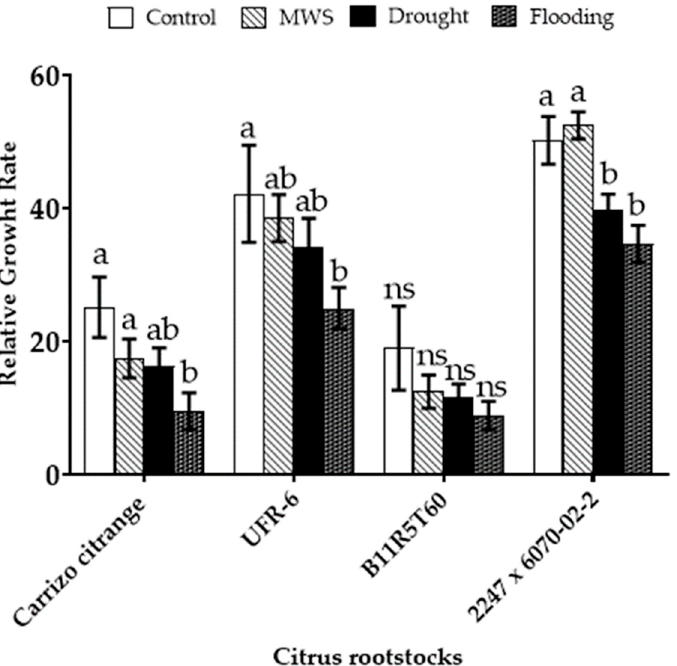
Figure 3. Relative growth rate (RGR; day − 1 ) after 30 days (D30) under four water treatments (Control, MWS, Drought, and Flooding) and with four citrus rootstocks assayed (Carrizo citrange, UFR-6, B11R5T60, and 2247 x 6070-02-2). Values in columns with different letters indicate statistical differences among treatments for each rootstock by Fisher’s test ( p < 0.05). MWS: Medium Water Stress; ns: not significant.